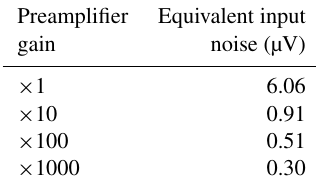
Table 1. Equivalent input noise test